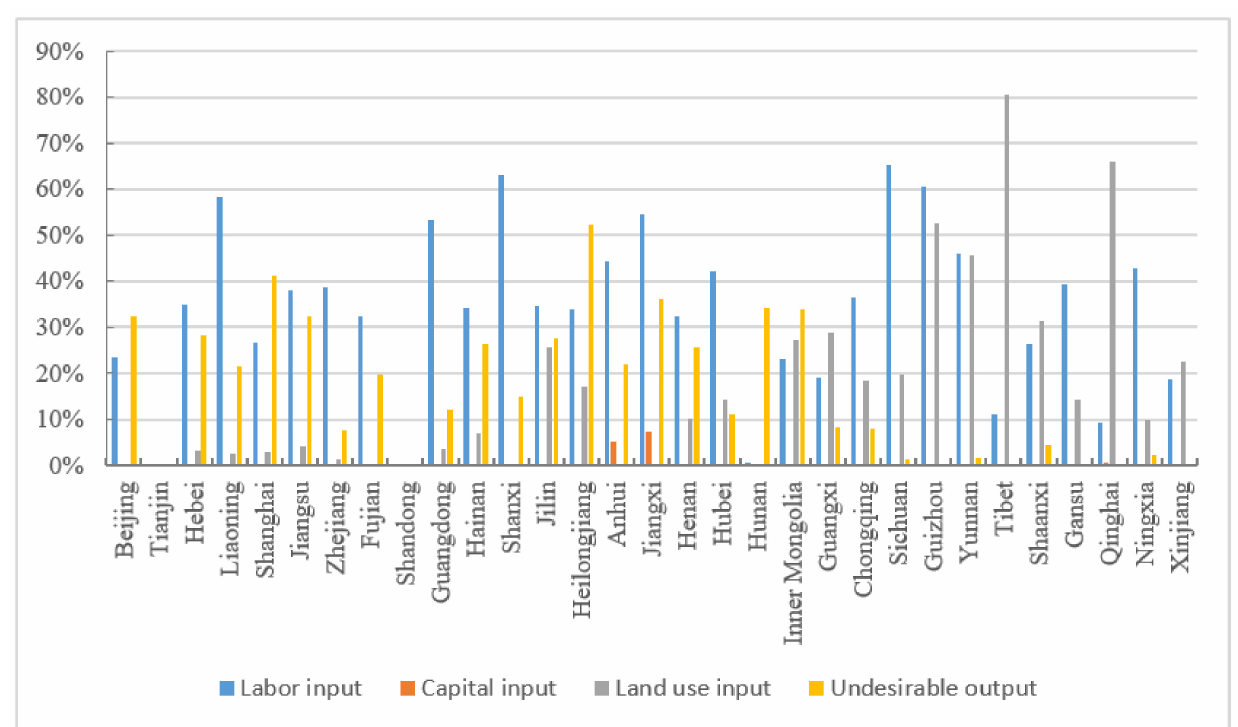
Figure 3. Average redundancy rate of input and output variables in China’s 31 provincial mining industries from 2007 to